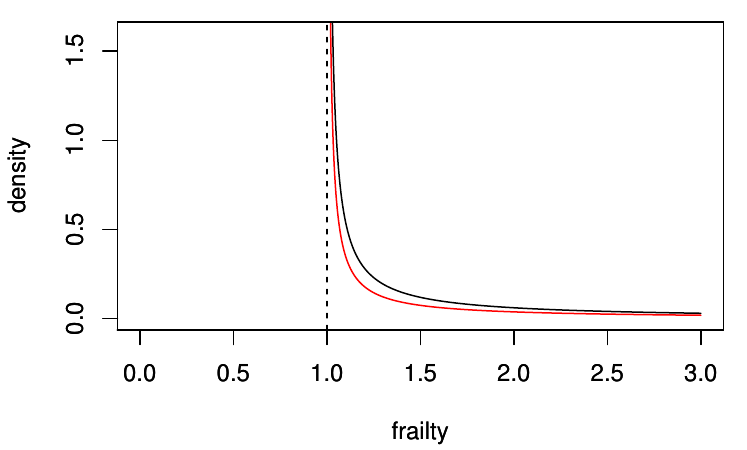
Figure 5. Probability density function of the estimated shifted gamma distribution. The black and red lines show the results for males and females,